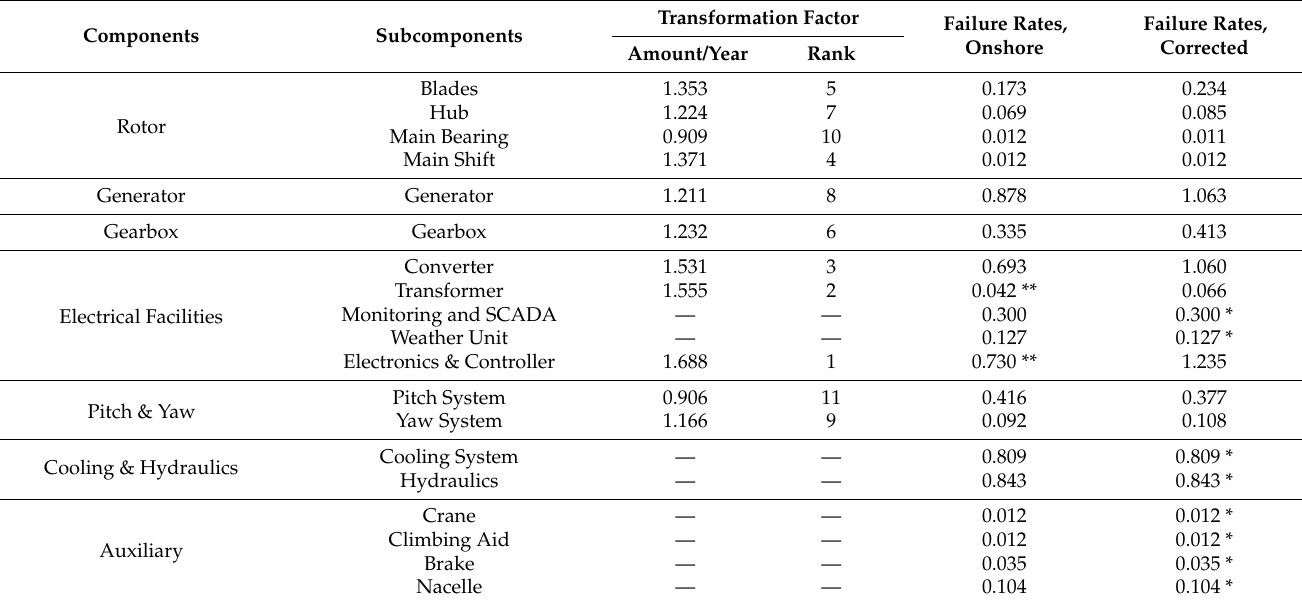
Table 12. Failure rates and the corresponding transformation factors of subcomponents.